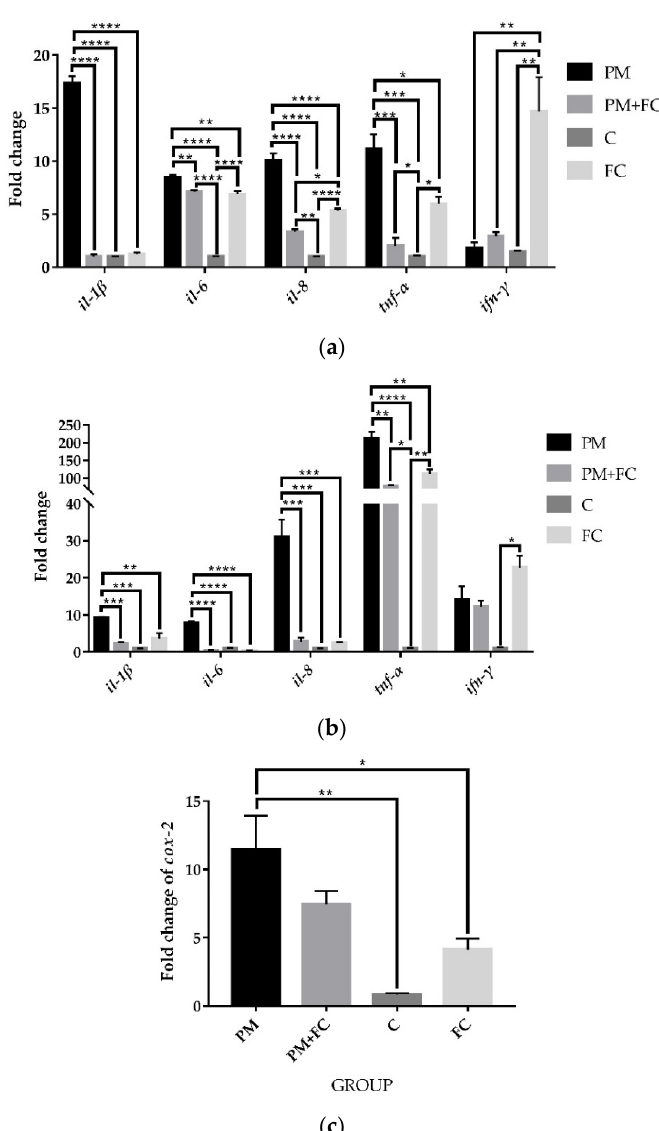
Figure 2. Fold changes of inflammatory cytokines in cells: ( a ) fold changes of inflammatory cytokines in A549 cells after treatment for 6 h; ( b ) fold changes of inflammatory cytokines in THP-1 cells after treatment for 2 h; ( c ) fold change of cox-2 in A549 cells after treatment for 2 h. * p < 0.05, ** p < 0.01, *** p < 0.001, **** p <